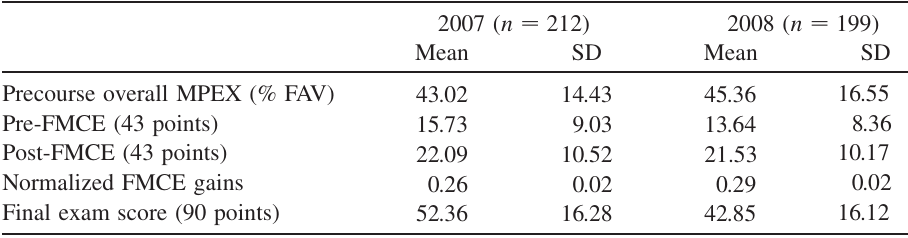
TABLE II. Average scores and standard deviation (SD) of MPEX favorable, FMCE, and final exam scores in the years 2007 and